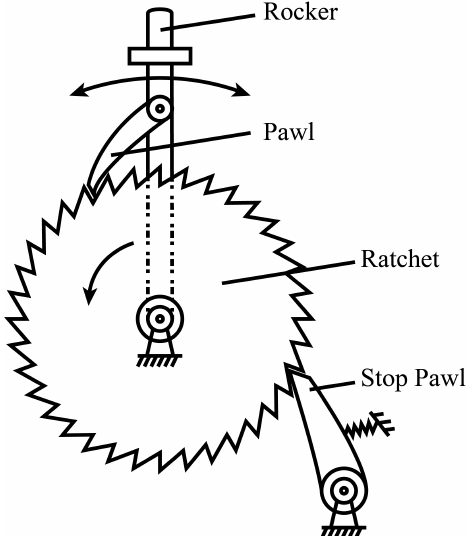
Figure 5. The principle diagram of ratchet wheel motion in